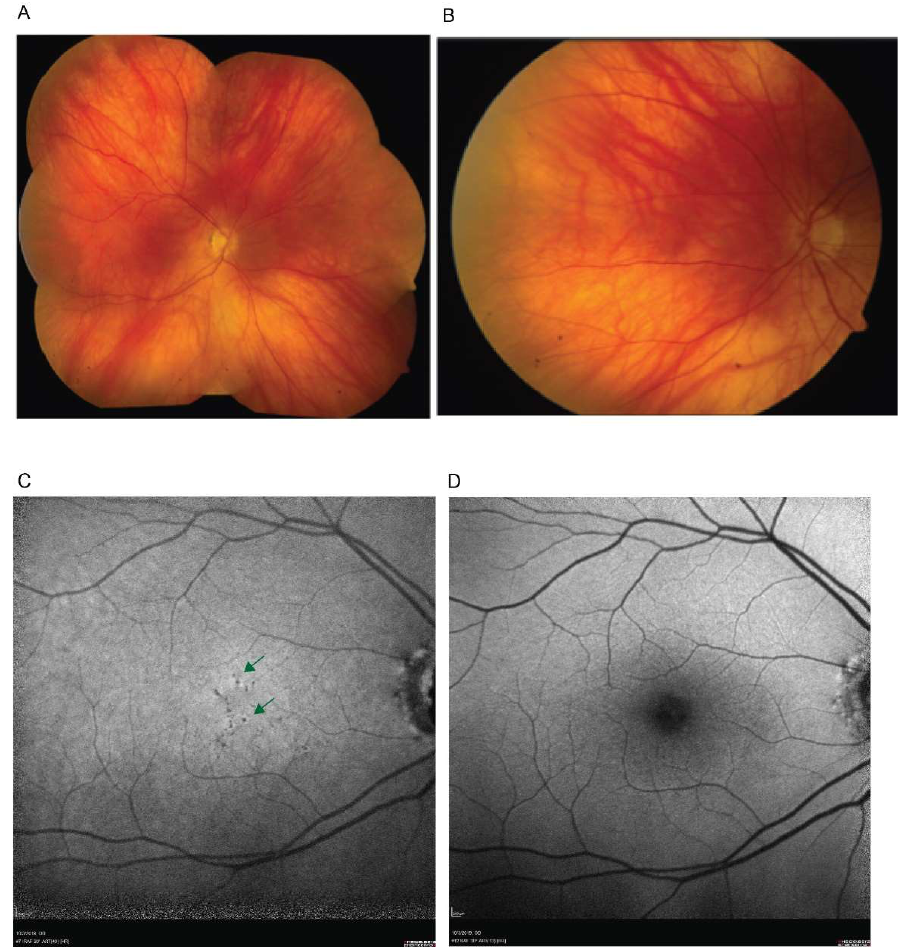
Figure 1. En face retinal imaging demonstrating retinal findings. ( A). A color fundus photography photomontage shows a normal blonde fundus. (B) A magnified image of the central retina demonstrates small faintly depigmented round lesions (green arrows) near the foveal center. (C & D). Fundus autofluorescence imaging using near-infrared (NIR-FAF) (C) and short-wavelength (SW-FAF) (D) excitation lights. Arrows on the NIR-FAF image (C) points to round dark, hypo-autofluorescent, depigmented lesions; SW-FAF image (D) is within normal limits. Only right eye shown for clarity, left eye had similar findings.